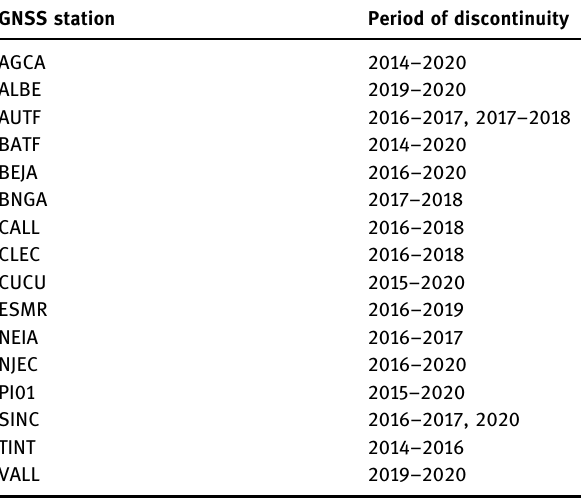
Table 4: GNSS stations with periods of discontinuities in